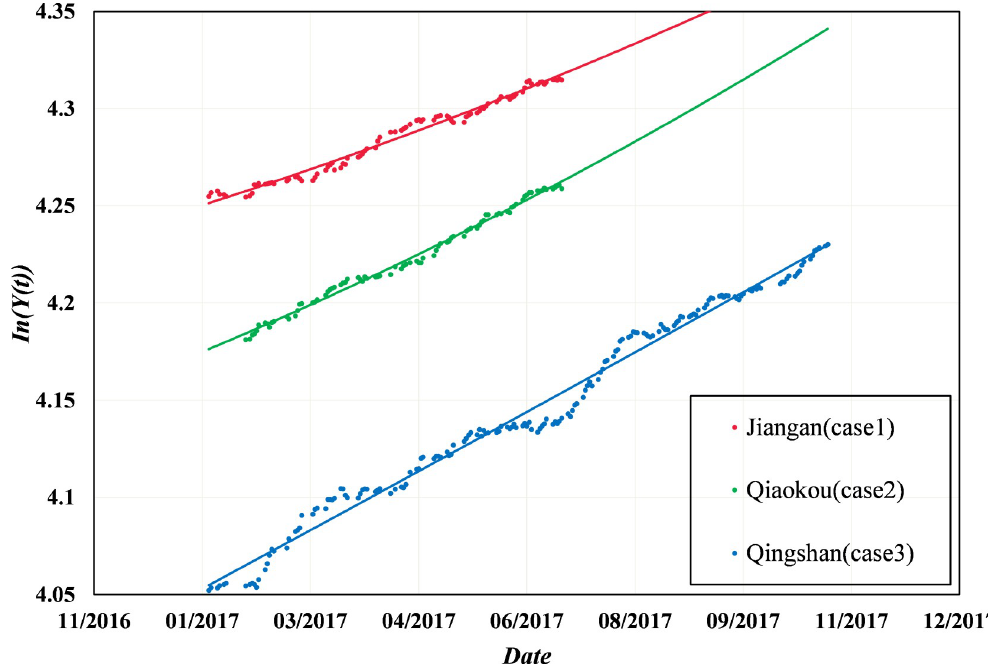
Fig 8. Exponential growth analysis with three case